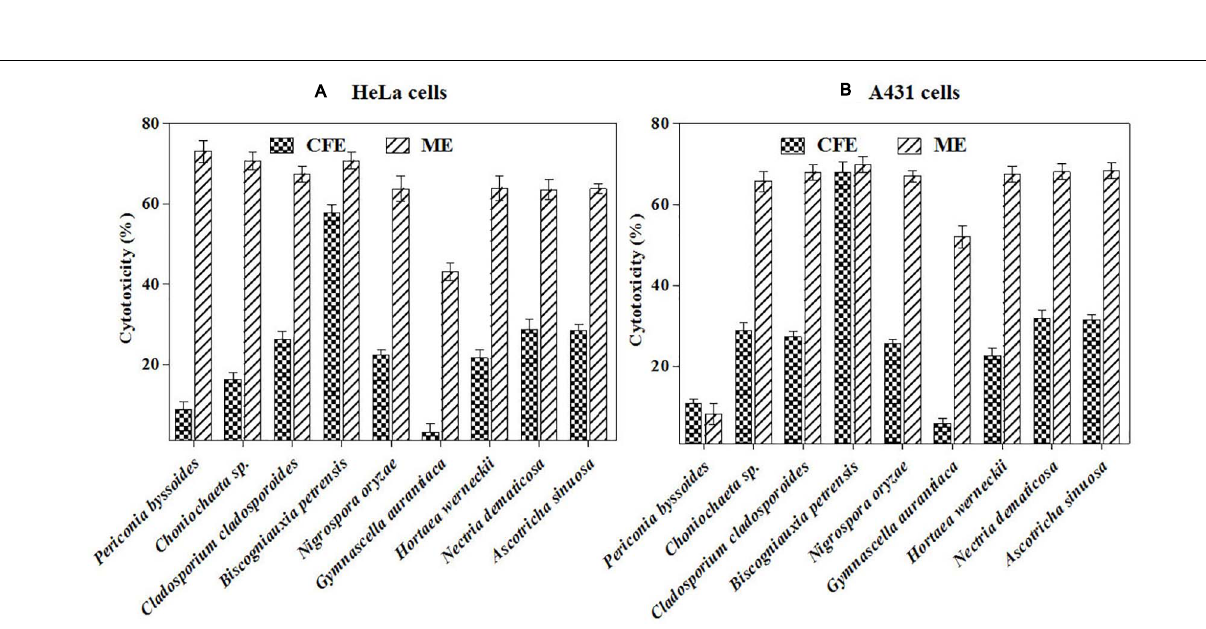
Frontiers in Microbiology |